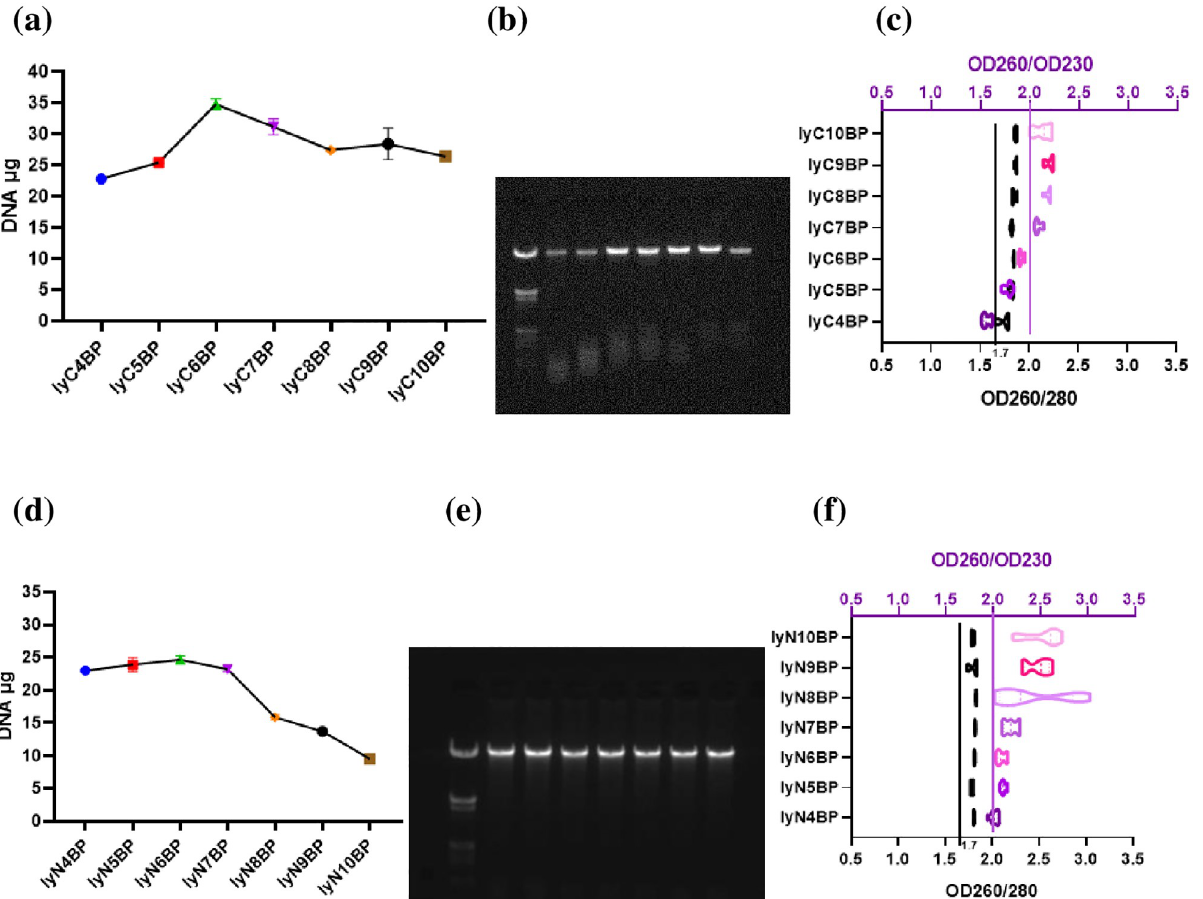
Fig 6. (a) The capacities of lysis buffer C (pH 4 to 10), and elution buffer Q (pH 9) for extracting DNA on BP, using the new protocol. (b) DNA electrophoresis of the related samples (Marker, � lyC4,5,6,7,8,9,10BP; � lyC and the number refers to lysis buffer C and the pH of lysis buffer C). (c) The OD260/OD280 (black) and OD260/OD230 (purple) purity ratios of the related samples. (d) The capacities of lysis buffer N (pH 4 to 10), and elution buffer Q (pH 9) for extracting DNA on BP, using the new protocol. (e) DNA electrophoresis of the related samples (Marker, � lyN4,5,6,7,8,9,10BP; � lyN and the number refers to lysis buffer N and the pH of lysis buffer N). (f) The OD260/OD280 (black) and OD260/OD230 (purple) puriy ratios of the related samples.